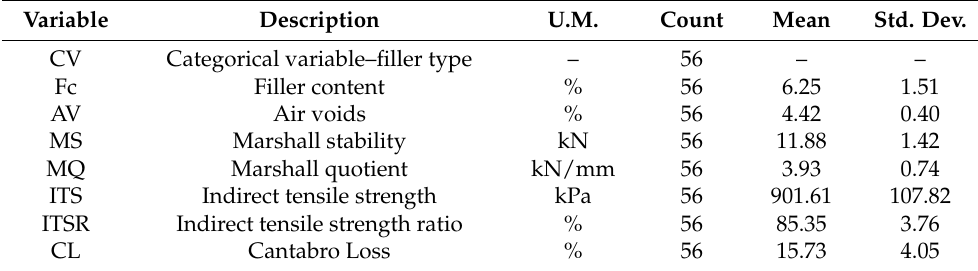
Table 6. Statistical description of CatBoost model